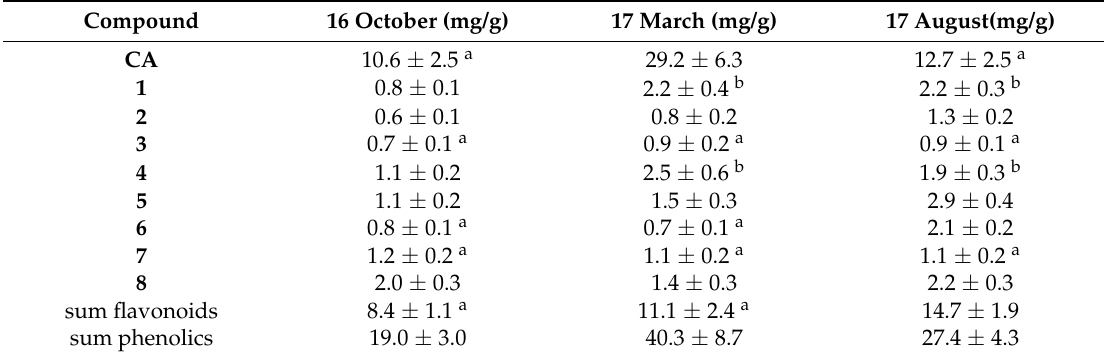
Table 4. Quantitative amounts of individual flavonoids and chicoric acid in leaves of Ruppia cirrhosa collected in October 2016, March 2017 and August 2017.